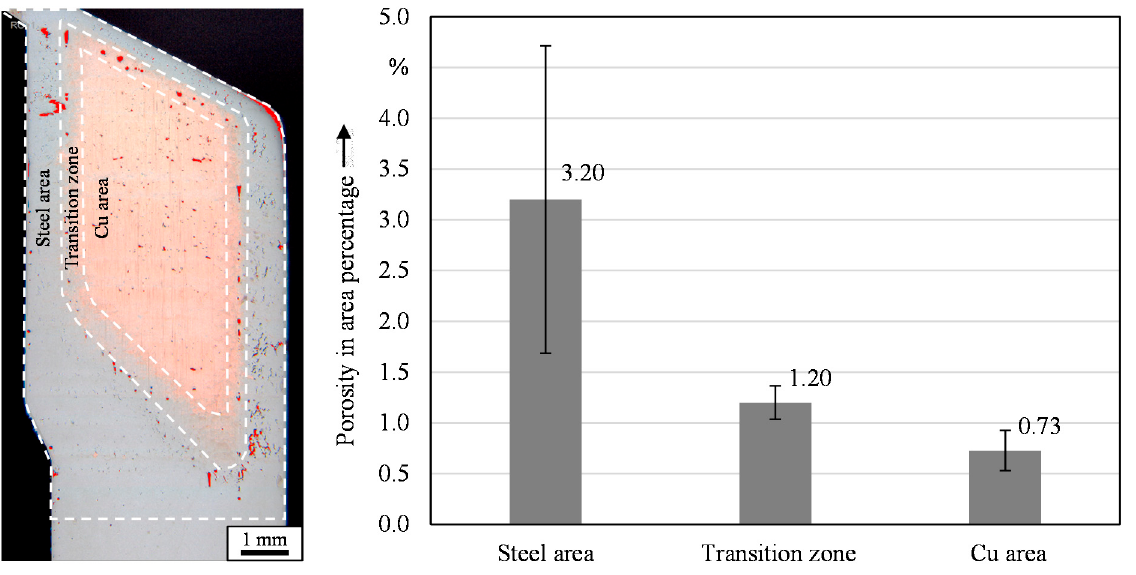
Figure 6. Porosity analysis for the different material zones. Analyzed defects are colored red in the left example image.